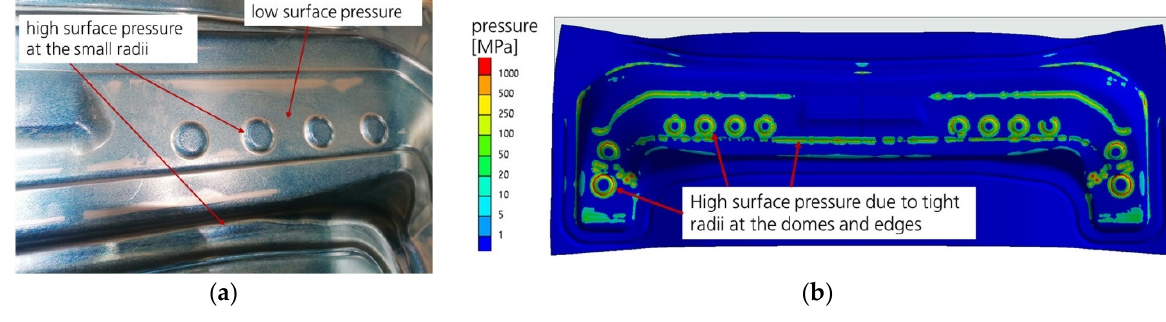
Figure 11. ( a ) Real first spotting pattern before mechanical reworking and ( b ) in simulation with unoptimized tool geometry including machine elasticity and sheet thinning at 6 MN press force.